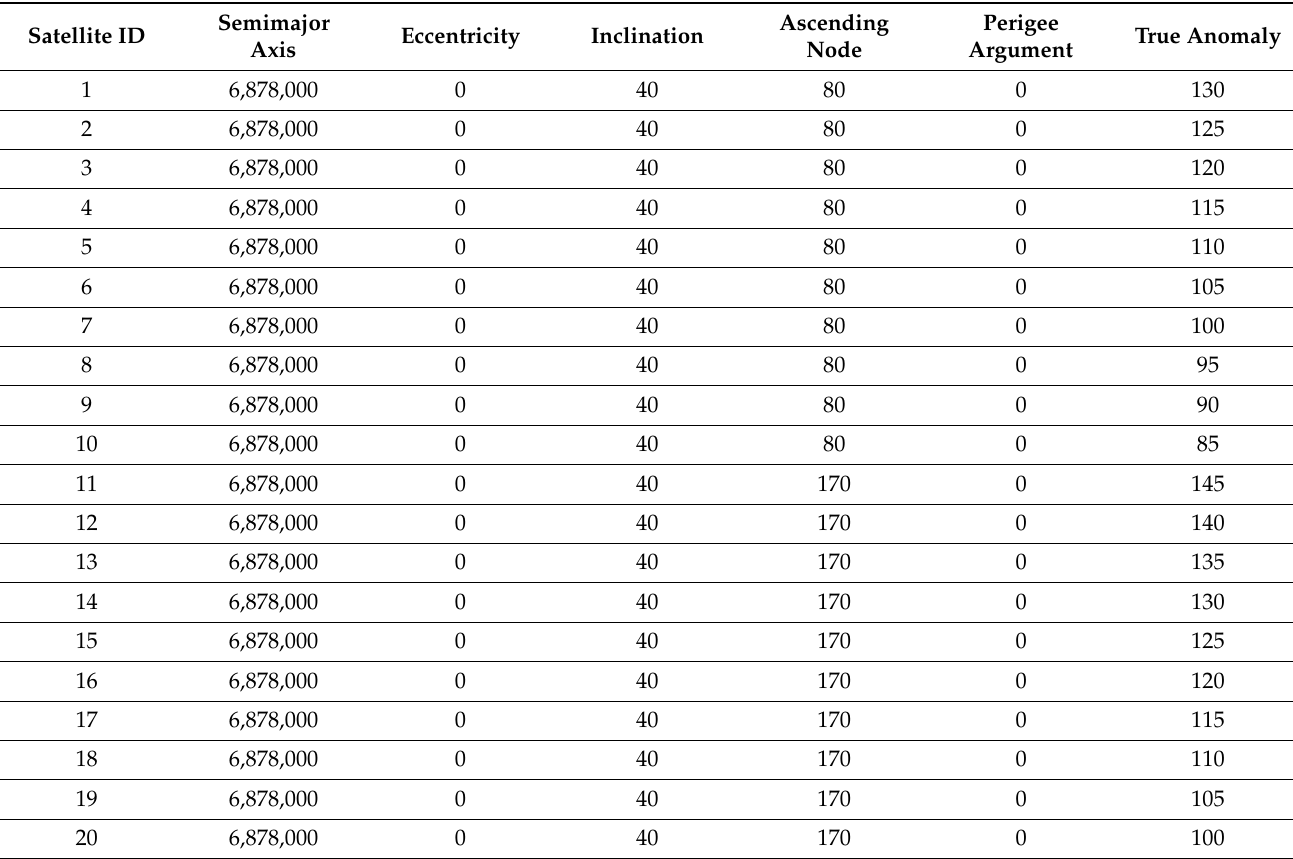
Table 1. Parameters for the satellites.